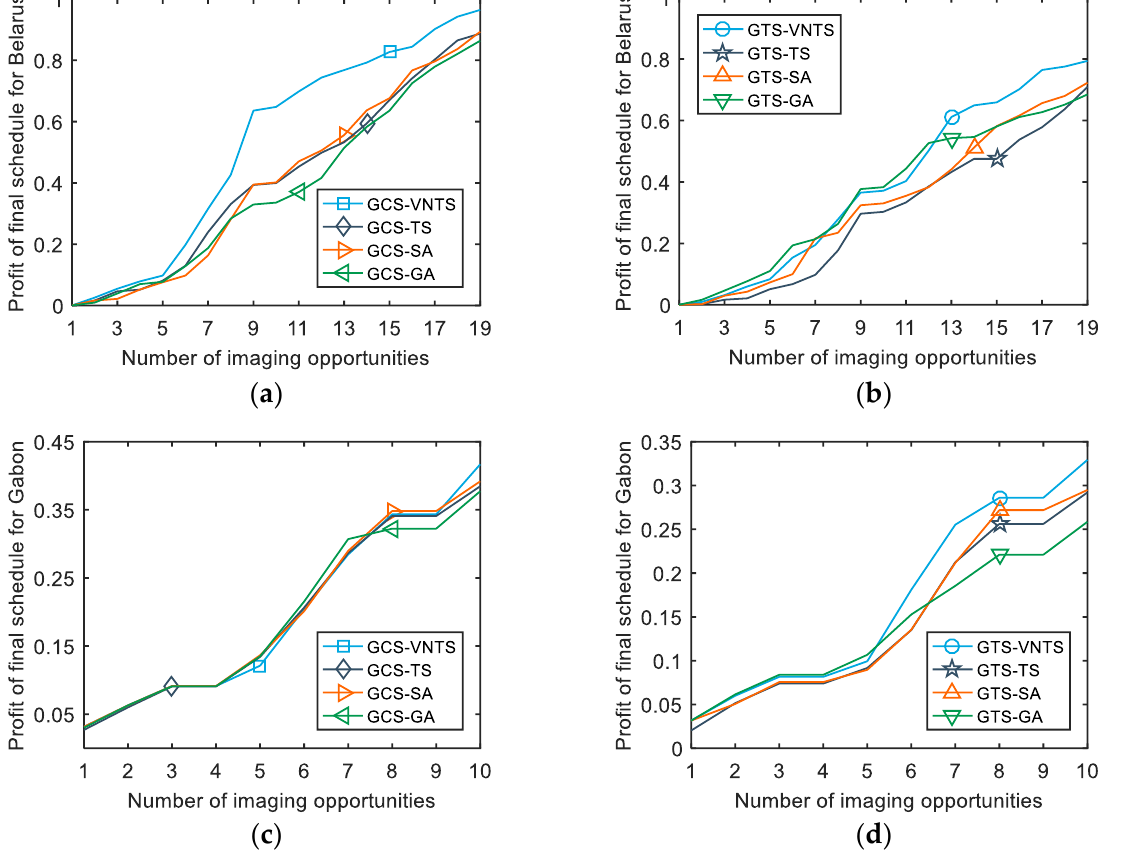
Figure 10. The profit of the final schedule versus the number of imaging opportunities. ( a ) The profit of the final schedule for Belarus using the GCS strategy; ( b ) the profit of the final schedule for Belarus using the GTS strategy; ( c ) the profit of the final schedule for Gabon using the GCS strategy; ( d ) the profit of the final schedule for Gabon using the GTS strategy.